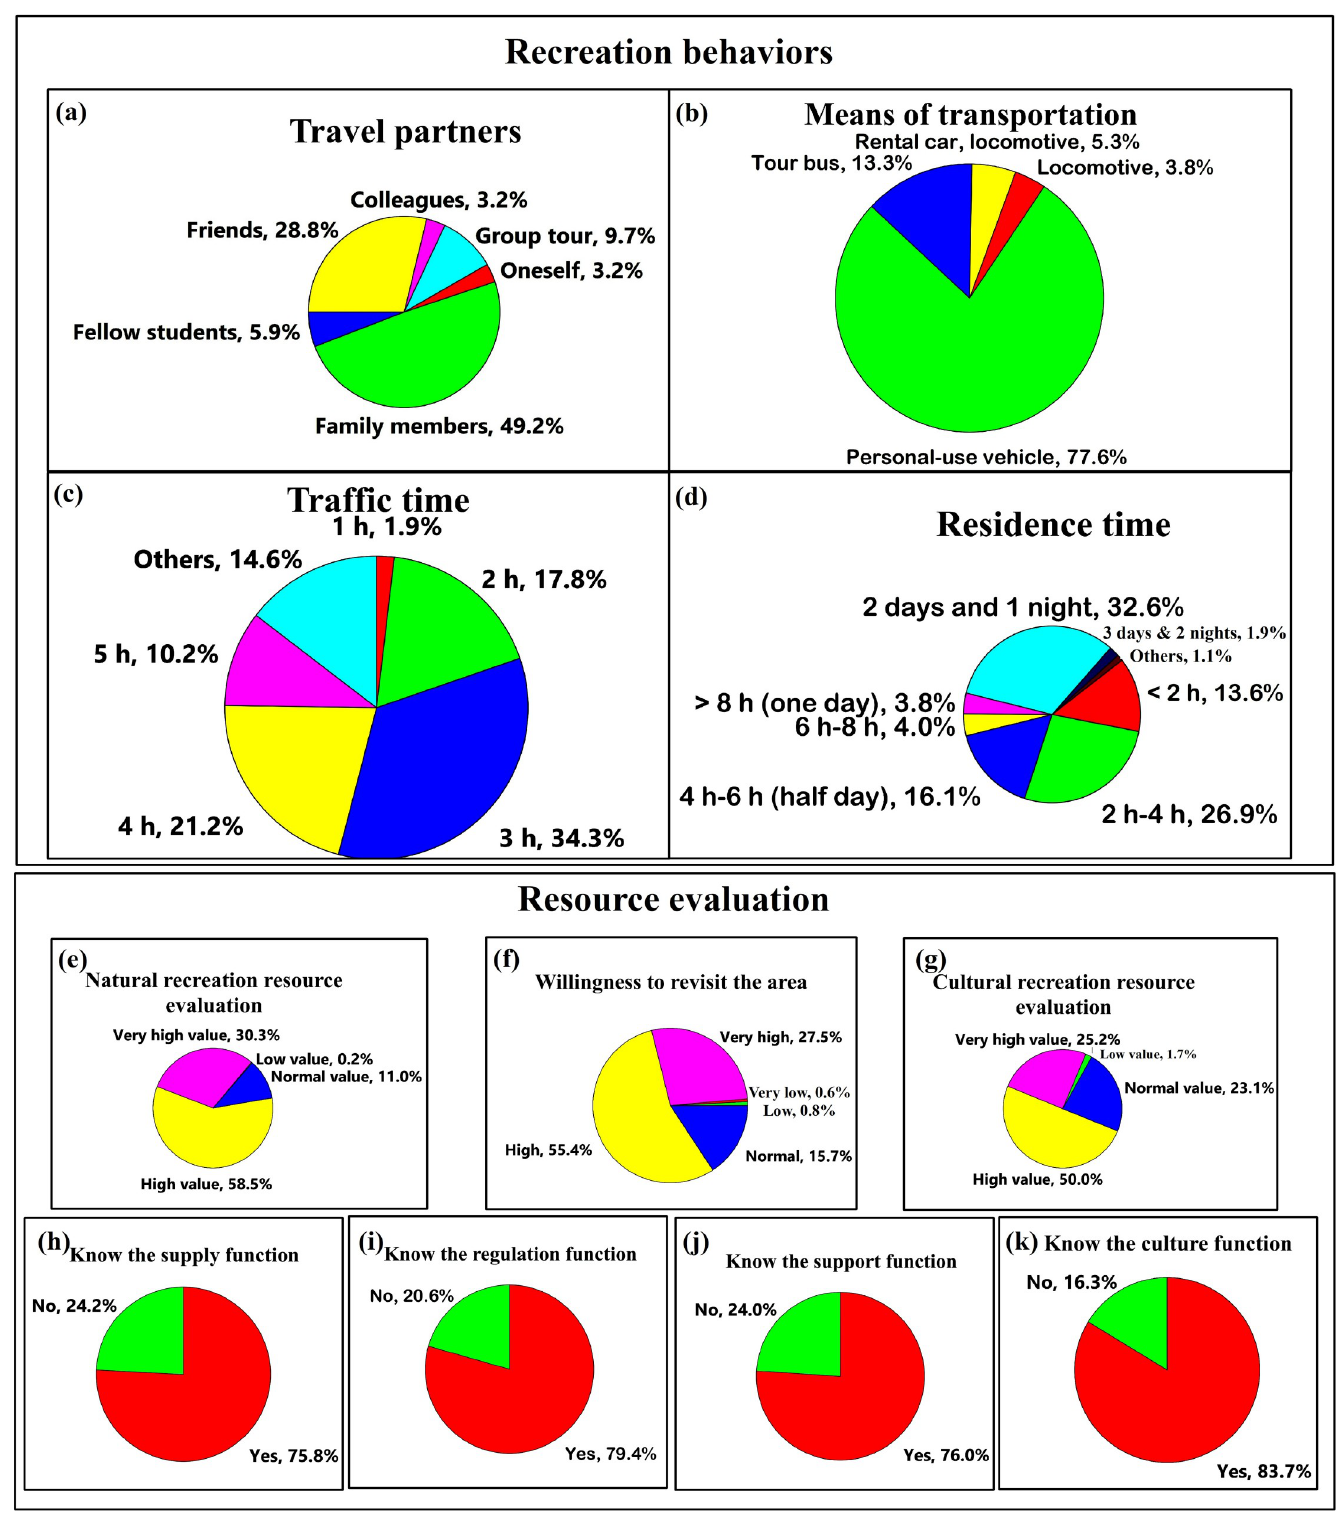
Fig 1. The behavior and evaluations of resources by tourists visiting the Guanwu National Forest Recreation Area in Taiwan. Data for this analysis were divided into two parts: “recreation behaviors” and “resource evaluation”; recreation behaviors included information on travel partners, means of transportation, traffic time, and residence time; the resource evaluation included data for tourist evaluations of the natural and cultural recreation resources, willingness to revisit the area, and awareness of the supply, regulation, support, and culture functions. https://doi.org/10.1371/journal.pone.0257835.g001 PLOS ONE | https://doi.org/10.1371/journal.pone.0257835 September 30,